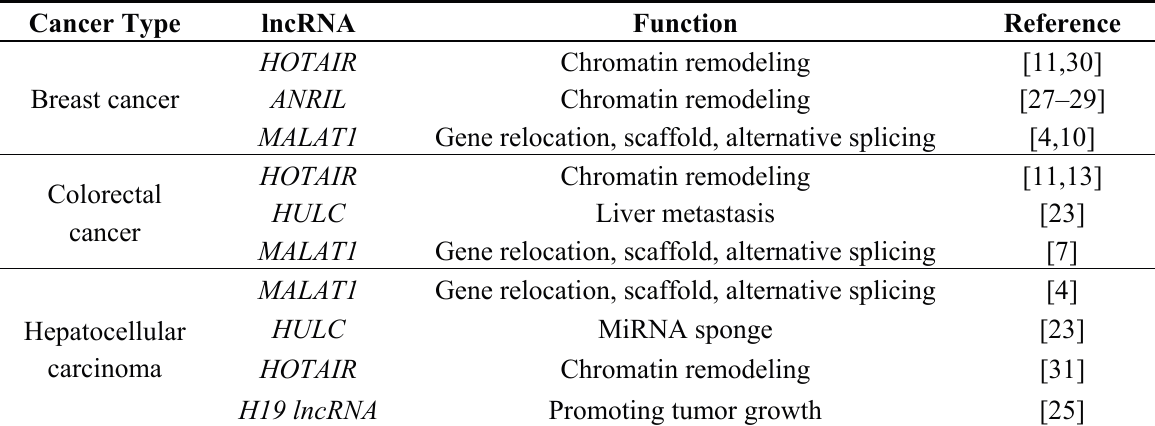
Table 1. Cancer-related